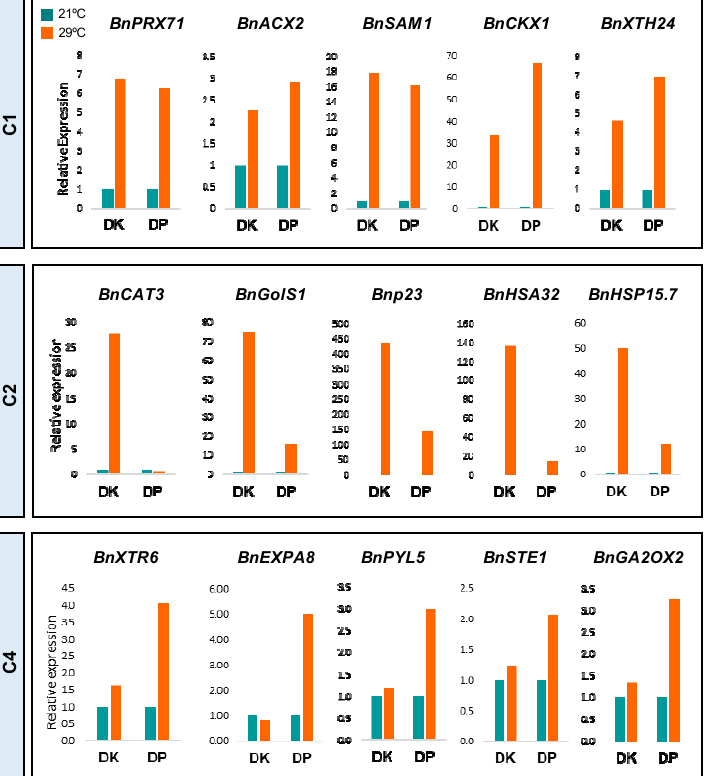
Figure 6. Transcriptional dynamics are altered in response to warm temperatures in B. napus roots. Gene expression levels of several genes representative of the main GOs enriched in three of the most significant transcriptional response patterns identified by hierarchical clustering analysis of Drakkar (DK) and Duplo (DP) root tips grown at 21 ◦ C compared to 29 ◦ C. As measured using quantitative RT-PCR (qPCR), relative gene expression values of genes from Cluster 1 were related with the response to oxidative stress ( BnPRX71 ), fatty acids ( BnACX2 ), cell wall ( BnXTH24 ), as well as ethylene biosynthesis ( BnSAM1 ) and cytokinin catabolism ( BnCKX1 ) and showed similar pattern of expression in both varieties. Meanwhile, relative gene expression values of genes from Cluster 2 were related to response to hydrogen peroxide ( BnCAT3 ) and high light intensity ( BnGols1 ) together with core heat-shock response genes (HSR) such as chaperones ( BnP23 ) and heat-shock proteins (HSPs) ( BnHSA32 and BnHSP15.7 ). Cluster 4 was related with cell wall biogenesis and organization ( BnXTR6 and BnEXPA8 ), as well as hormonal regulation, such as ABA signalling ( BnPYL5 ), brassinosteroids ( BnSTE1 ), and gibberellin ( BnGA20 × 2 ) metabolism. All of these confirmed the differential expression patterns between varieties in response to warming. All the experiments were performed using three biological and three technical replicates. Expression values were normalized with those of BnACT7 (Chen et al., 2010). The second and third biological replicates are shown in Figure S3C. The remaining clusters comprised genes showing differential expression between the two genotypes and are therefore more likely to contain the genetic determinants of the variability in root response to warming conditions. Clusters 3, 4, and 6 represented genes that had an opposite expression in Duplo compared to Drakkar. We found genes that were repressed in Drakkar but less repressed or induced in Duplo (Cluster 3), induced in Duplo but less induced in Drakkar (Cluster 4), or repressed in Duplo but induced or less repressed in Drakkar (Cluster 6). Regarding the type of genes contained in these clusters, Cluster 3 (260 genes) was enriched in genes related to nitrate assimilation, metabolism, and transport ( BnNRT2.1 ) and to cell wall-related processes. Cluster 4 (352 genes) included genes in- volved in peroxidase activity, cell wall biogenesis and organization ( BnXTR6 , BnEXPA8 and BnXYL4 ), and abscisic acid (ABA) signaling ( BnPYL4 and BnPYL5 ). Thus, in Duplo, the